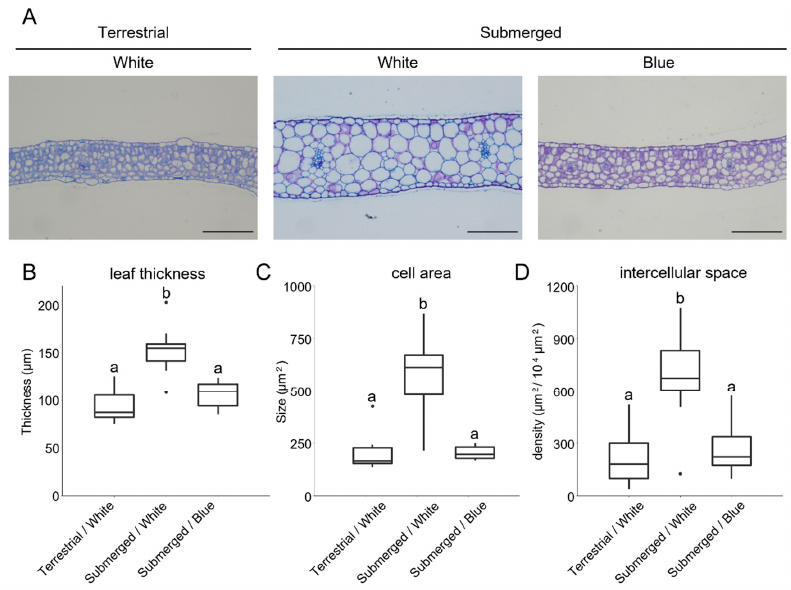
Figure 1. The effect of submergence upon leaf morphology and suppression under the blue-light conditions. ( A ) R. aquatica leaf cross-sections after 7 days of treatment (scale bars = 100 µm); a box plot of leaf thickness ( B ); the cell area size of the mesophyll cell ( C ); and the density of intercellular space ( D ) (mean ± SE, n = 10). The letters show the groups assigned based on the adjusted p -value obtained from the Tukey–Kramer test (the adjusted p -value < 0.01).